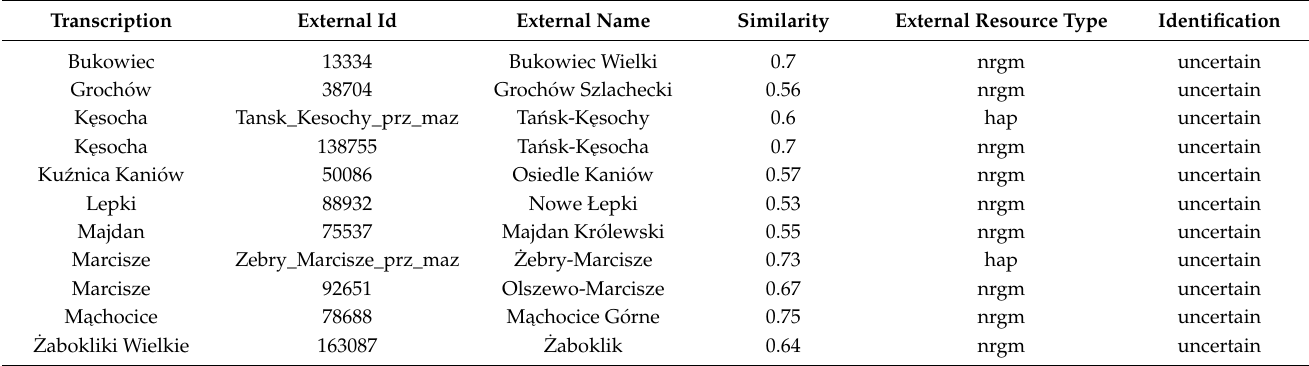
Table 3. Place names from ‘special maps’ with corresponding ones from NRGM/HAP are identified with a lower level of certainty, mostly because historical places do not have exact modern counterparts. If a place name occurs twice, it means it was identified with both